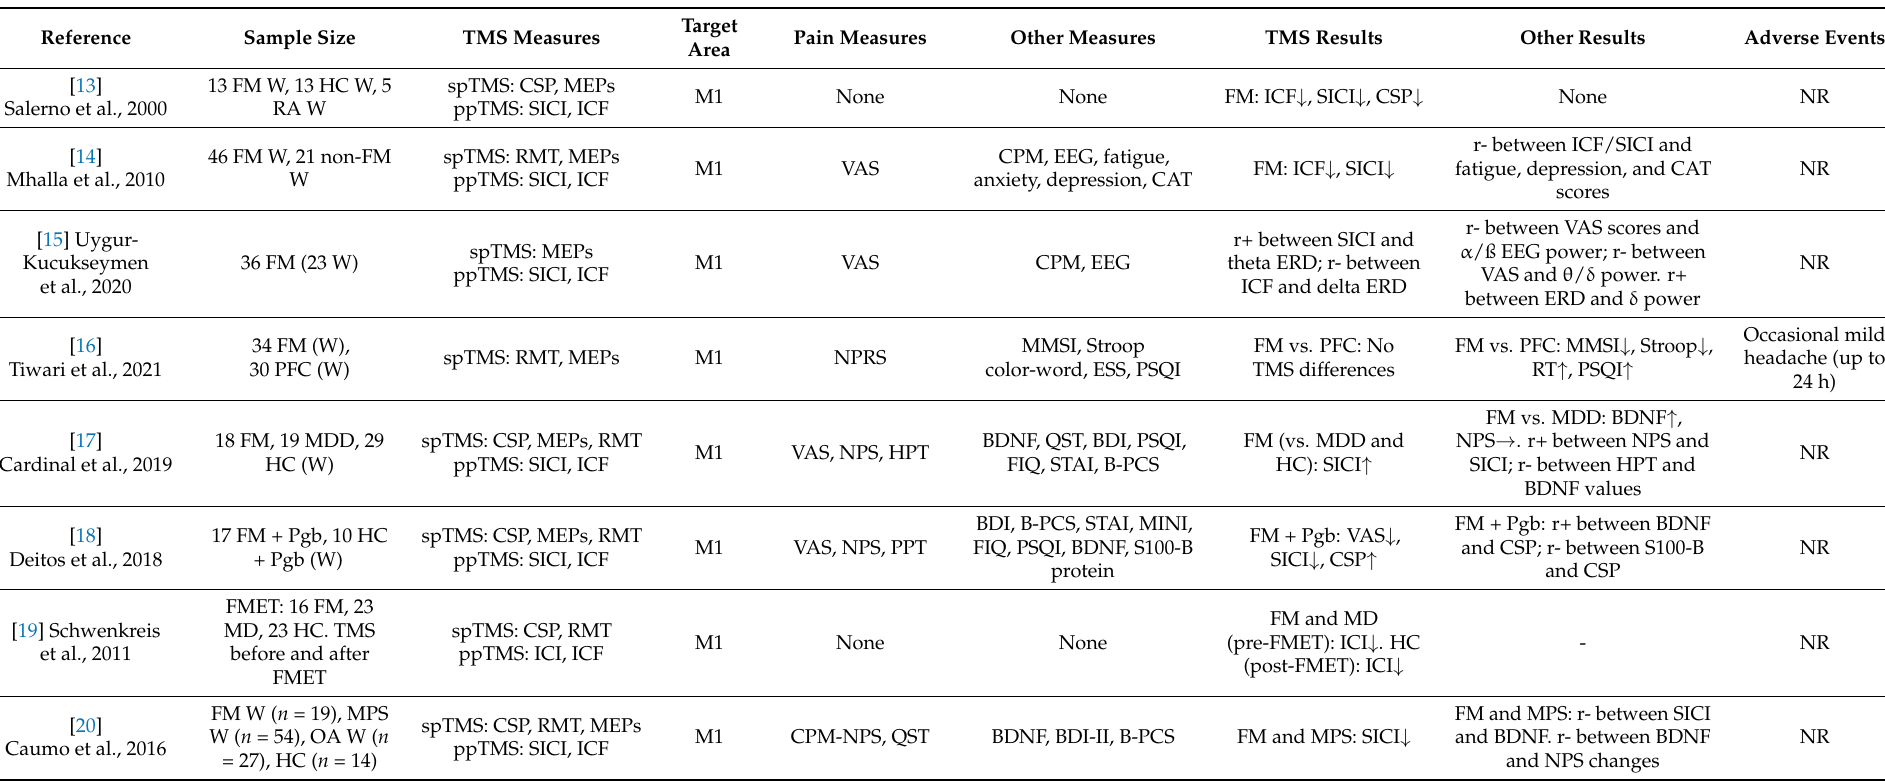
Table 1. Single- and double-pulse TMS protocols and results of relevant studies conducted to explore the neurobiological features of fibromyalgia